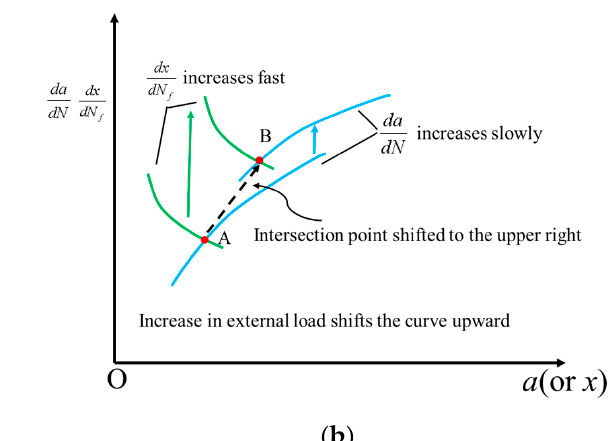
Figure 17. The boundary between crack initiation and propagation and its influencing factors. ( a ) The solution of the boundary and its relationship with nominal stress; ( b ) Influence of external load on dx